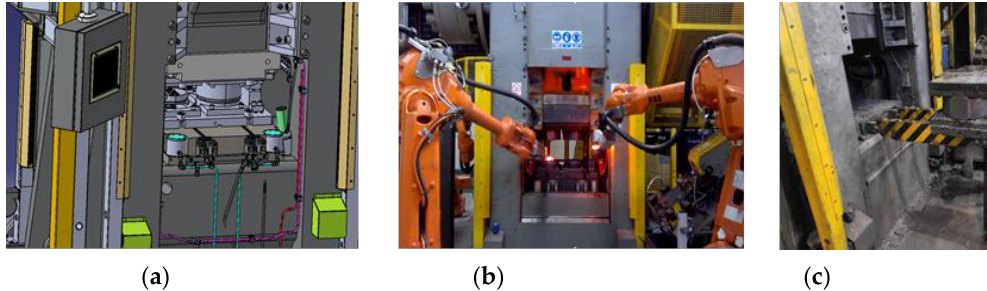
Figure 1. Photographs of: ( a ) the CAD model of the modernized press, ( b ) the main working portion of the modernized press during forging, ( c ) the assembly of the SMED instrumentation in the working area of the crank press. Table 1. Chemical compositions for tool steel and workpieces.